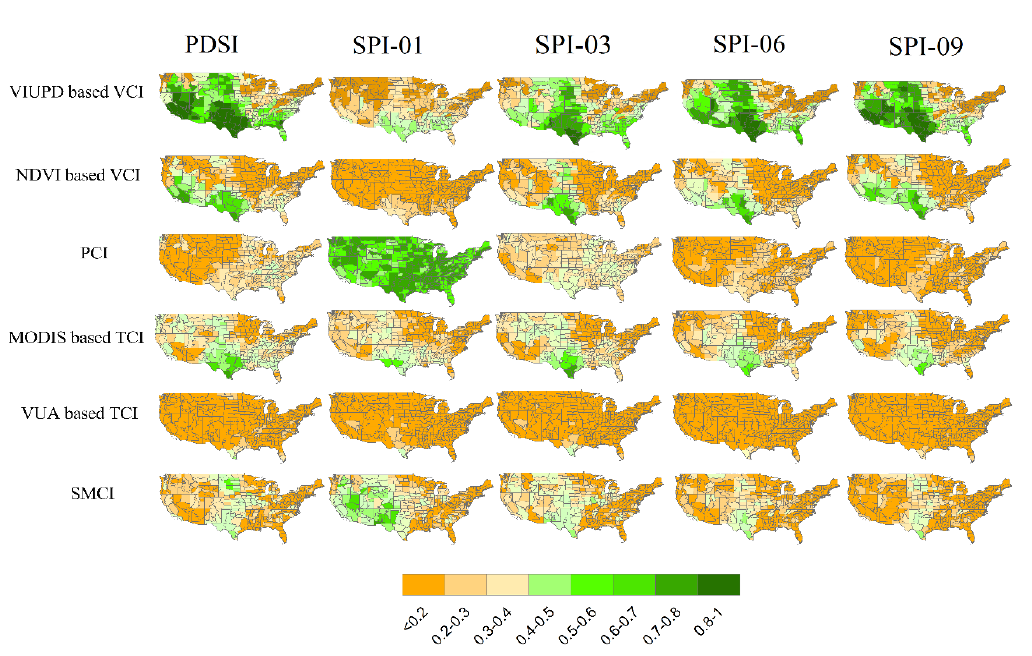
Figure 6. Spatial distribution of climate divisions with correlations (r-value) between VIUPD-derived VCI and other commonly used remote-sensing-based single drought indices with in situ drought indices for the entire growing season (April to October)